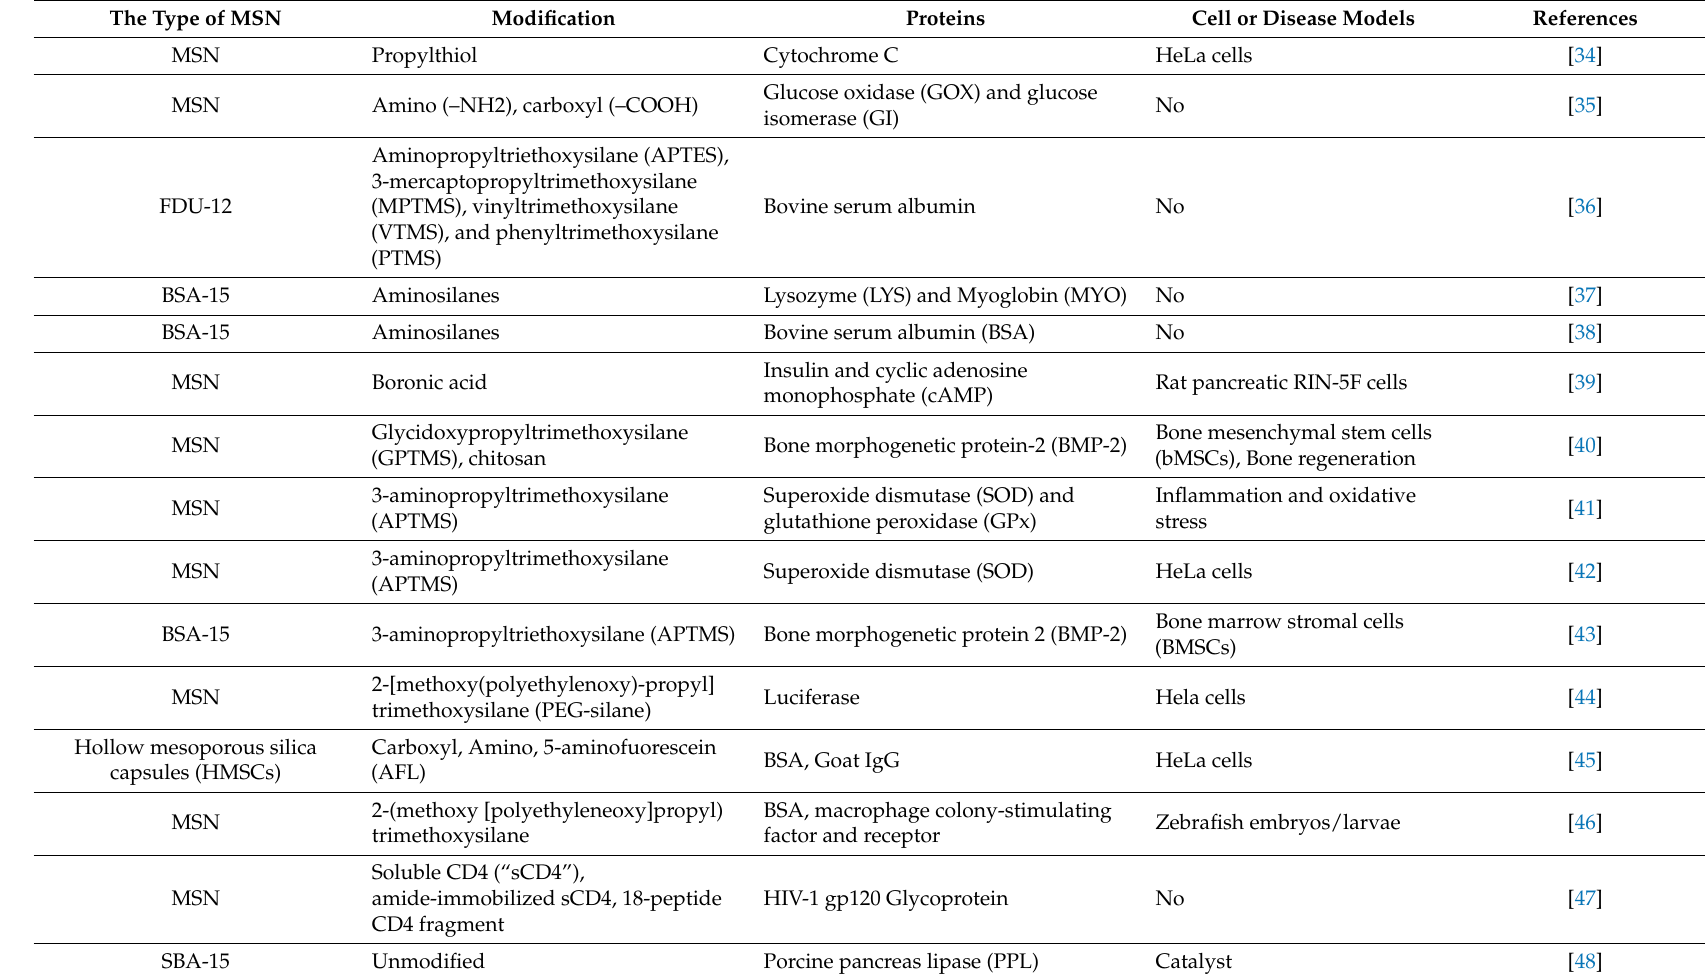
Table 1. Functional mesoporous silica nanoparticles for protein